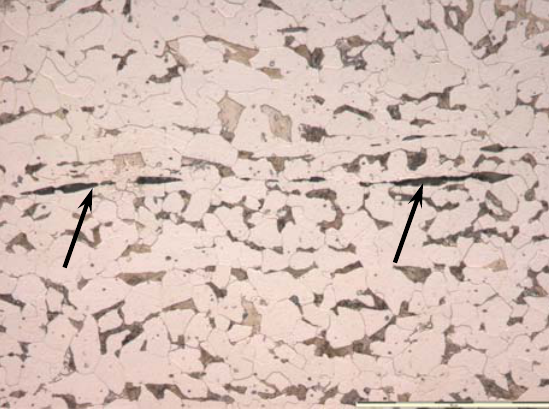
Figure 2: Micrograph of puddled steel circa 1880 showing sharp elongated MnS